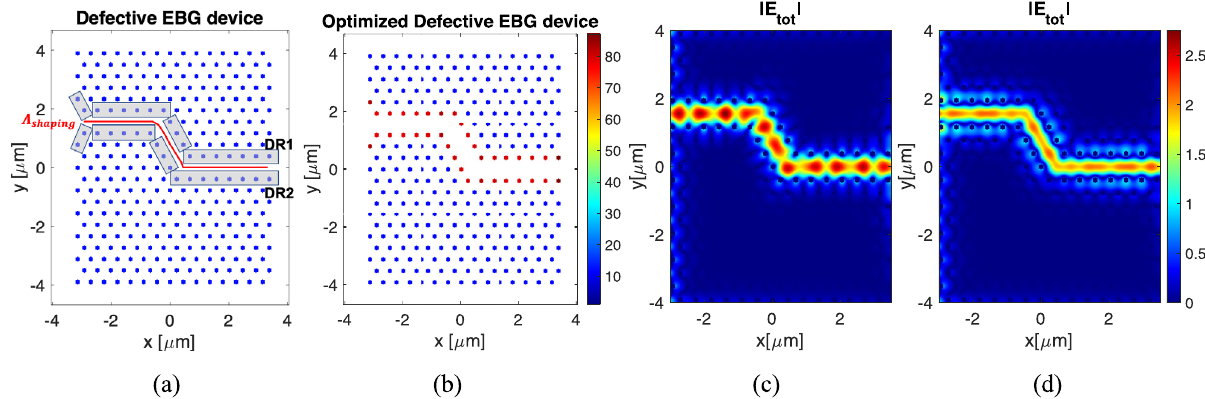
Fig. 4. Optimization of a double 60 ° bend waveguide. (a) Permittivity map of the defective EBG device where the DR is superimposed with light grey rectangle and (c) the corresponding electric fi eld amplitude distribution. (b) and (d) the same as (a) and (c) but for the optimized EBG device through the I-SMM [ e opt =83,77.7,79.2,78.3,79,79.5,82.4,79.9,80,79.7,79.5,82.7,80.1,79.7,78.8,79.3,79,87.1].